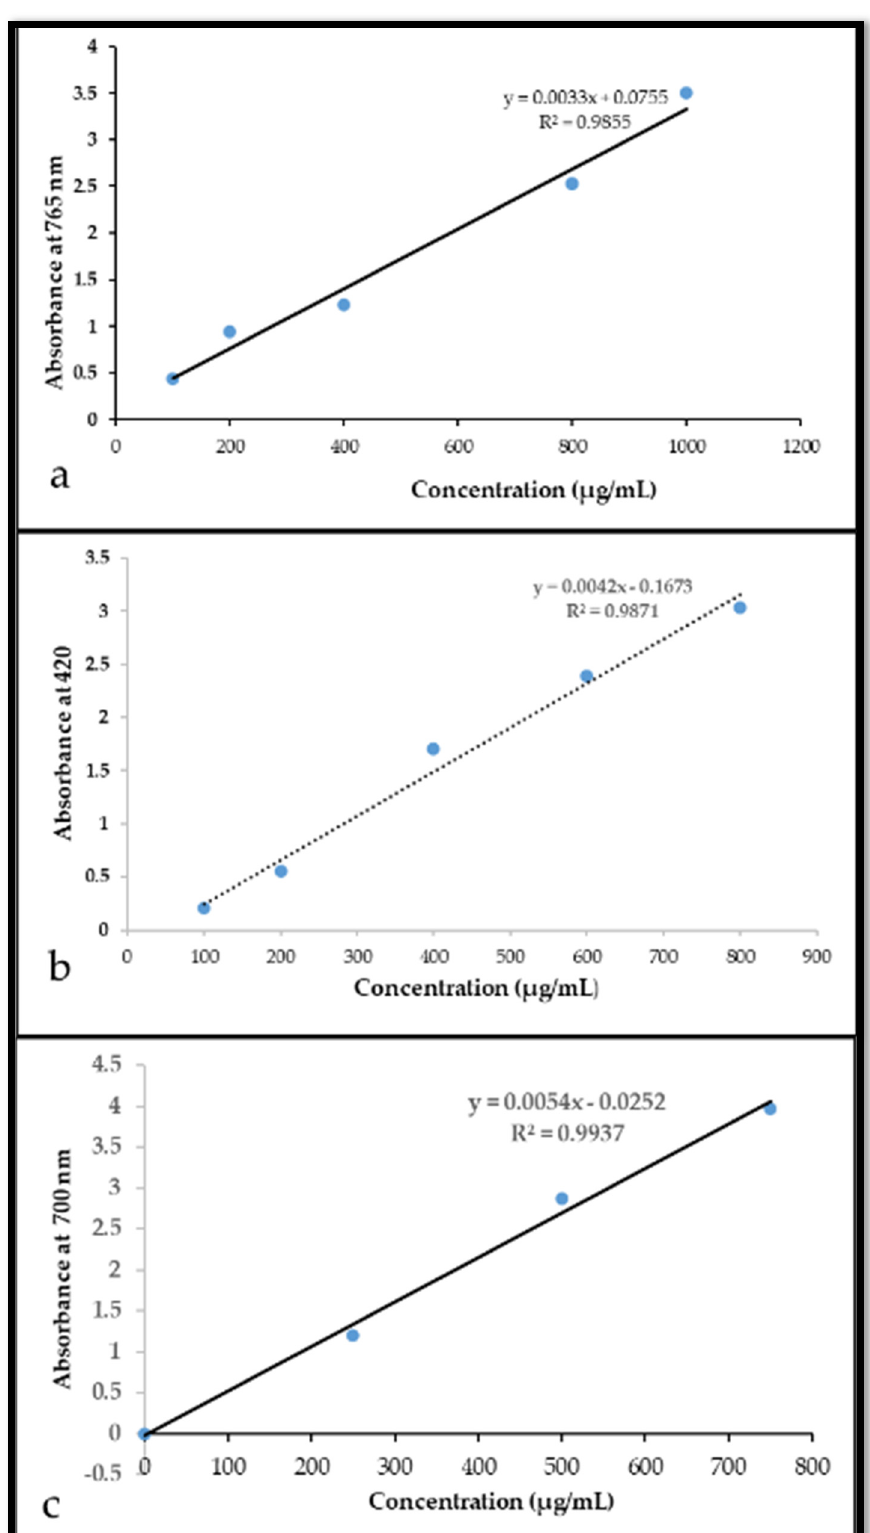
Figure 1. Shows calibration curves prepared from authentic standards ( a ) gallic acid, ( b ) quercetin, ( c ) tannic acid.